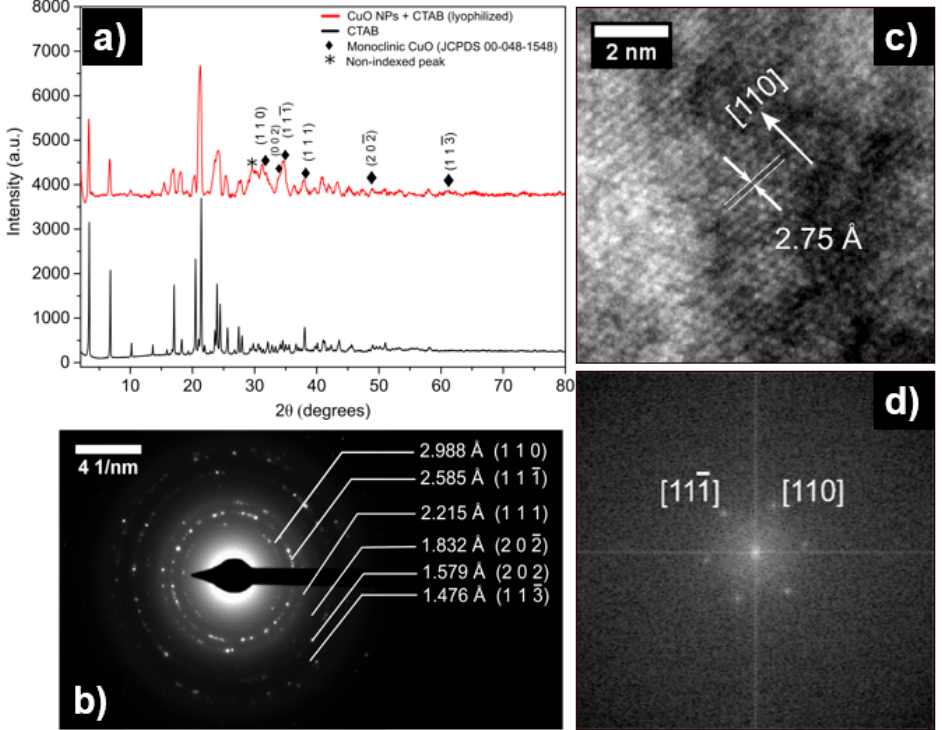
Figure 3. ( a ) X-ray powder diffraction patterns of CuO NPs and CTAB. ( b ) Selected areas of electron Figure 3. a ) X-ray powder diffraction patterns of CuO NPs and CTAB. b ) Selected areas of electron diffraction of CuO NPs. ( c ) HR-TEM and ( d ) Fast Fourier Transform (FFT) of CuO Table 2. Interplanar distances and intensity signals for different atomic planes in CuO (JCPDS 00-048-